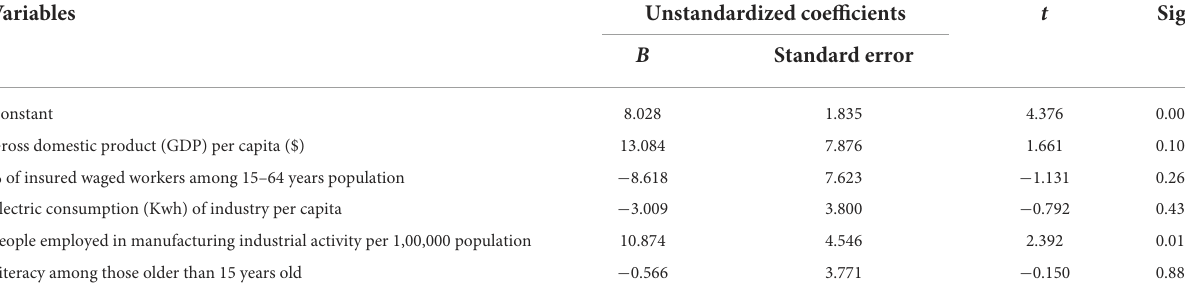
TABLE 4 Multiple linear analysis for the correlates of the attack rate increase ratio in the third wave of the COVID-19 outbreak in Turkey. Variables Unstandardized coefficients t Sig. B Standard